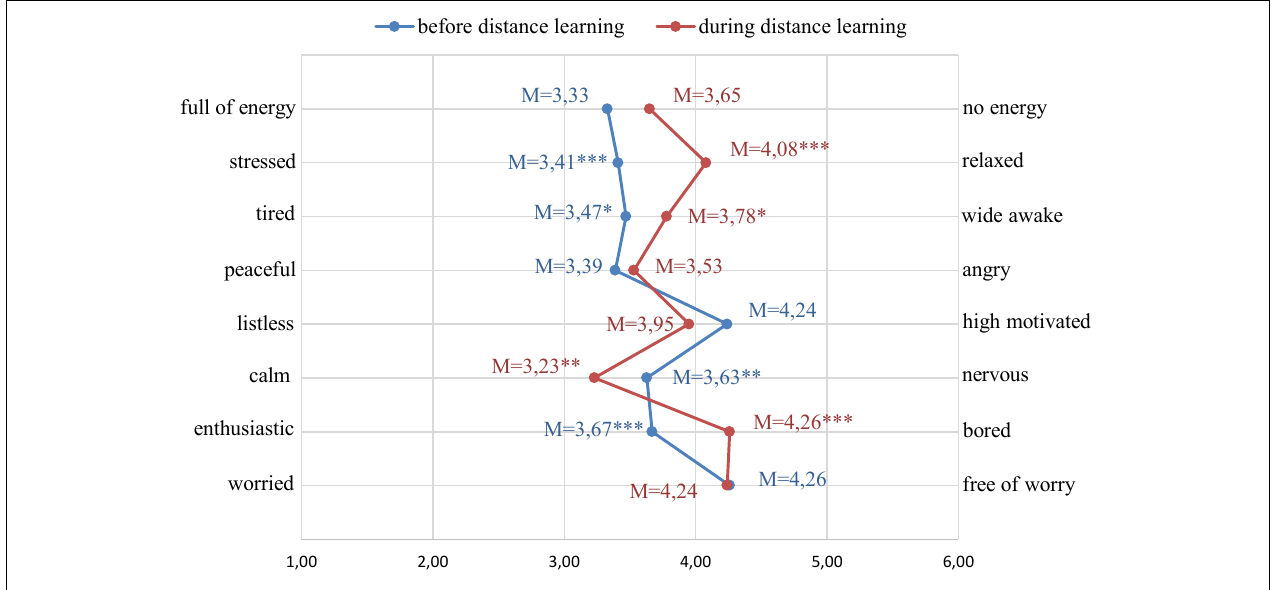
FIGURE 3 | Students’ positive and negative activation. ∗ p < 0.05; ∗∗ p < 0.01; ∗∗∗ p < 0.001.